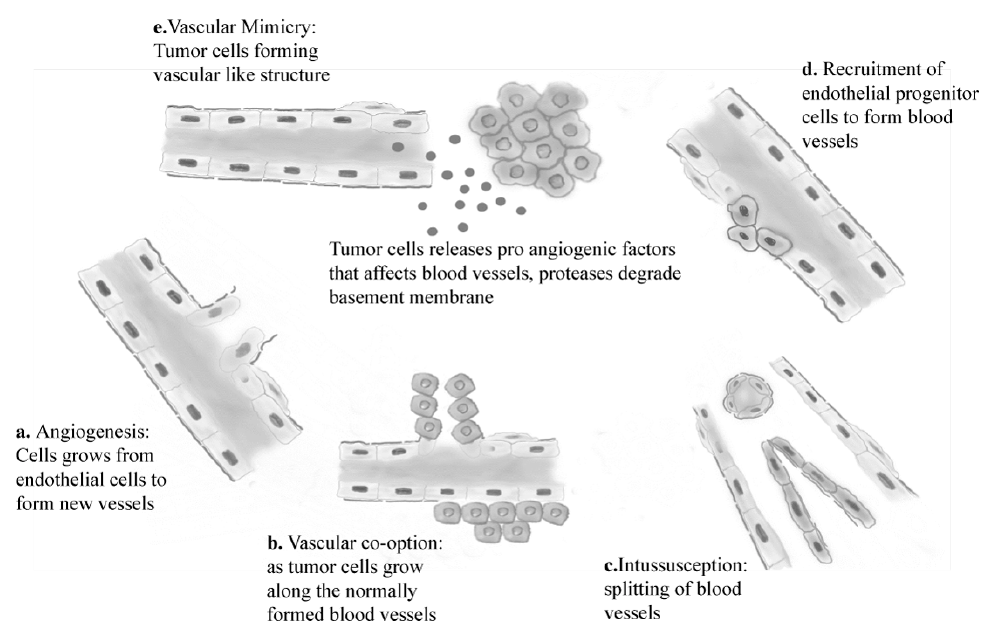
Figure 1. Graphic representation of various routes leading to new blood vessel formation within a tumor. ( a ) Angiogenesis, ( b ) vascular cooption, ( c ) intussusception, ( d ) endothelial progenitor recruitment, ( e ) vascular mimicry.